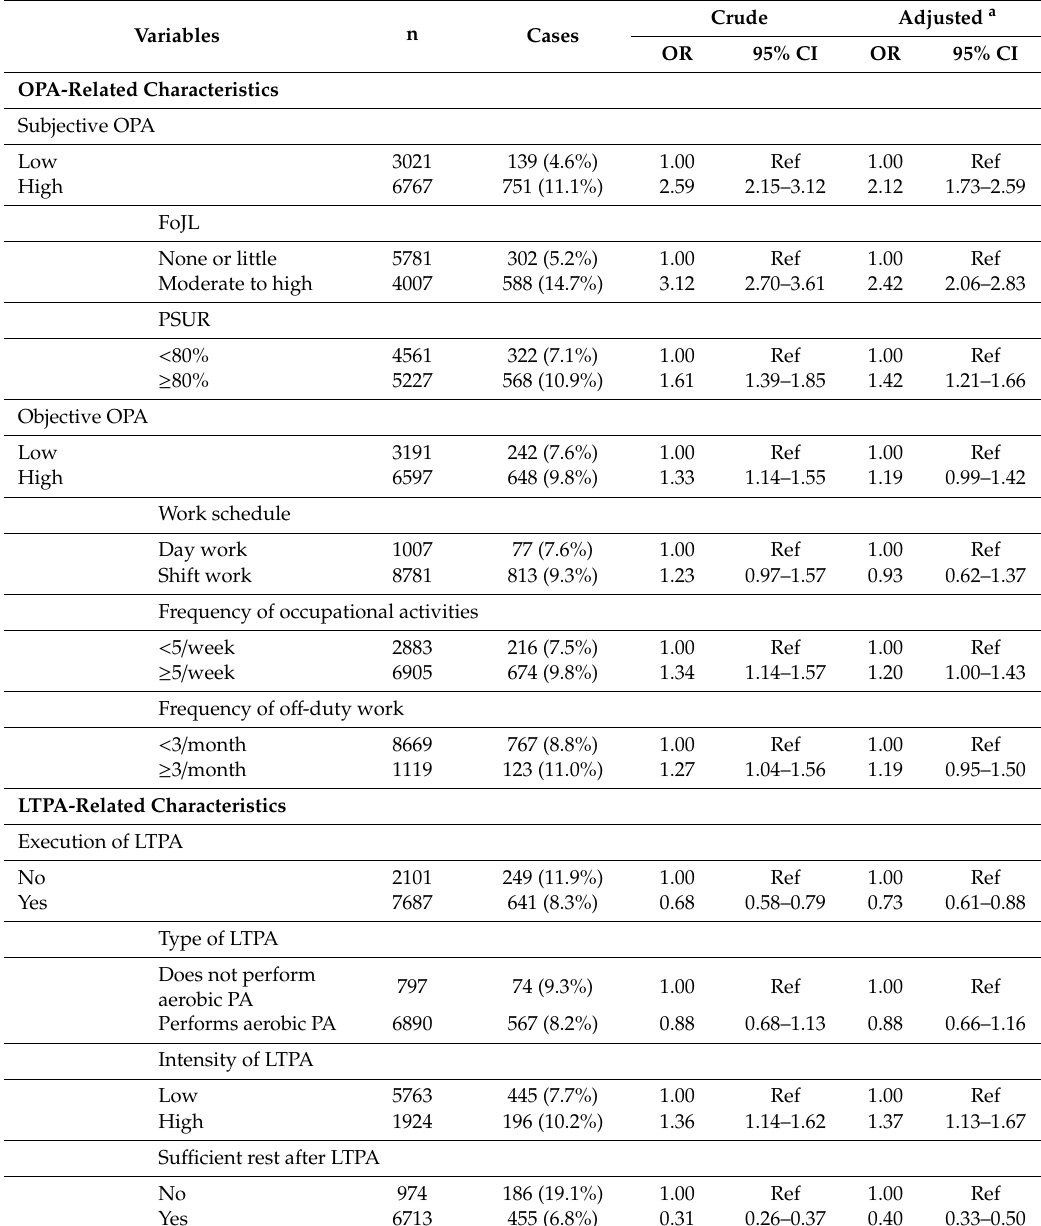
Table 3. Association between occupational physical activity (OPA), leisure time physical activity (LTPA), and insomnia. (OR = odds ratio; CI = confidence interval).